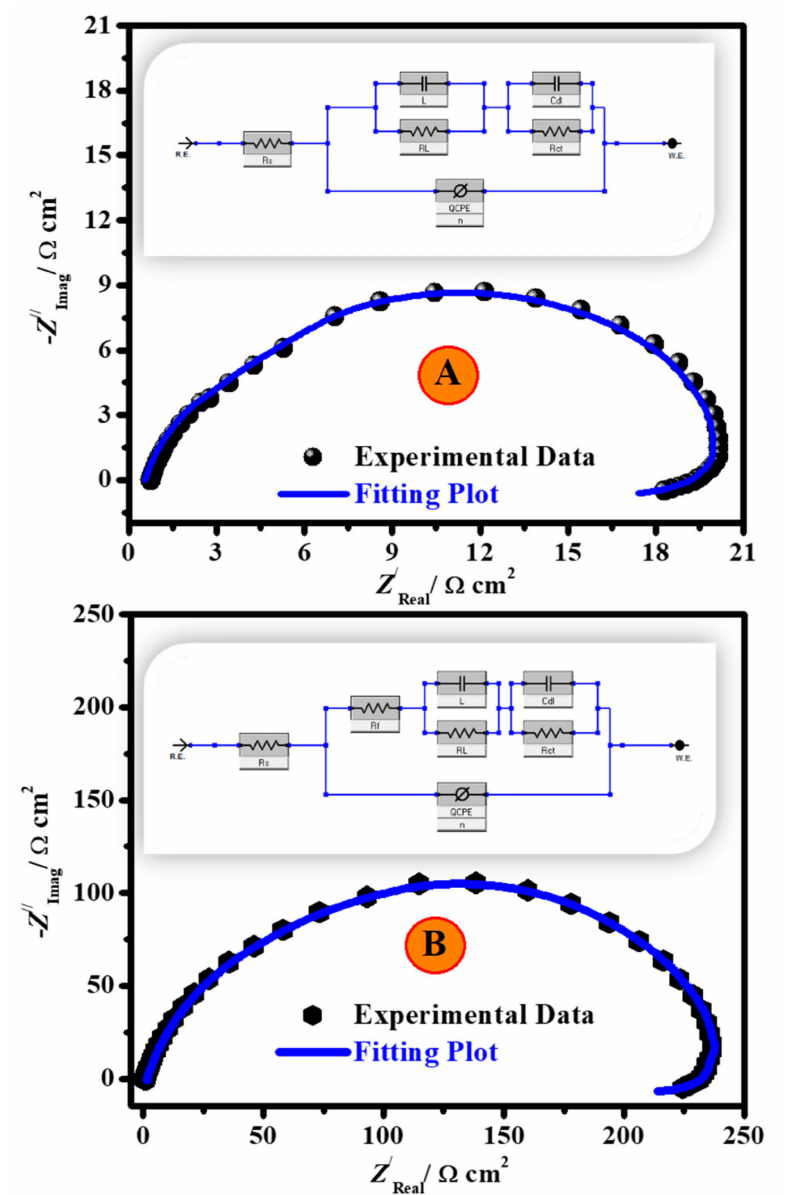
Figure 10. Nyquist profiles and fitted plots or duplex steel in blank 2.0 M H 2 SO 4 solution ( A ) and in the presence of 200 ppm of CH ( B ) at 50 ◦ C. Inset, equivalent circuit used to fit the EIS